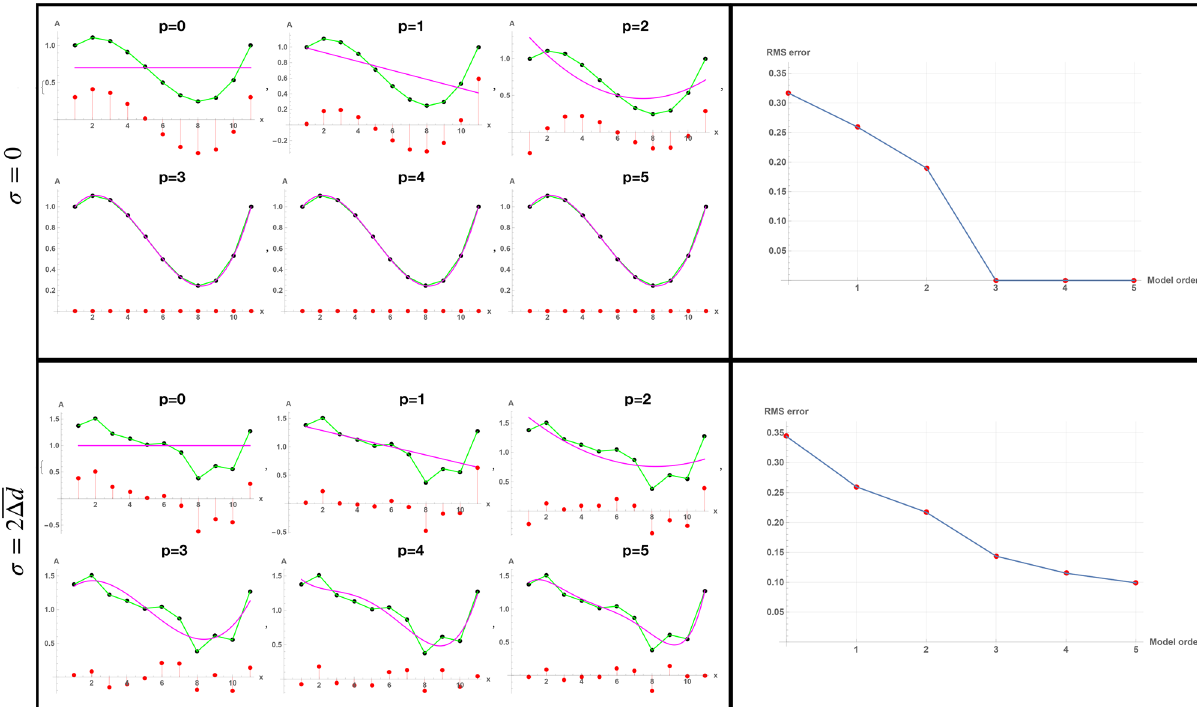
Figure 11. The model order problem. In the left column is shown the “data”, which consist of a third-order polynomial (green). The shape estimated from a standard least-squares fit is shown in magenta for hypothesized model order p . Deviations between the fit and the data at each point are shown as red dots. In the right column is shown the RMS error between the estimated shape and the data as a function of model order. In the top row 0 ) and the shape is faithfully reconstructed (i.e., RMS 0 ) at the correct model order there is no noise ( σ = ≈ 3 . Subsequent fits at higher order p > 3 also provide correct fits, but are no improvement over the correct p = 3 , as seen by the RMS vs model order plot on the right. The “optimal” fit order is thus estimated solution of p = 3 . In the bottom row the same analysis is performed to be where there is no RMS improvement, which is p = 2 � d (twice the mean but the data is now contaminated with random zero-mean Gaussian noise with σ = deviation of the data). The RMS versus model order plot on the right no longer shows a sharp distinction at the 3 and continue to decrease as the higher order components of the shape due to the noise are true value of p = increasingly well fit.